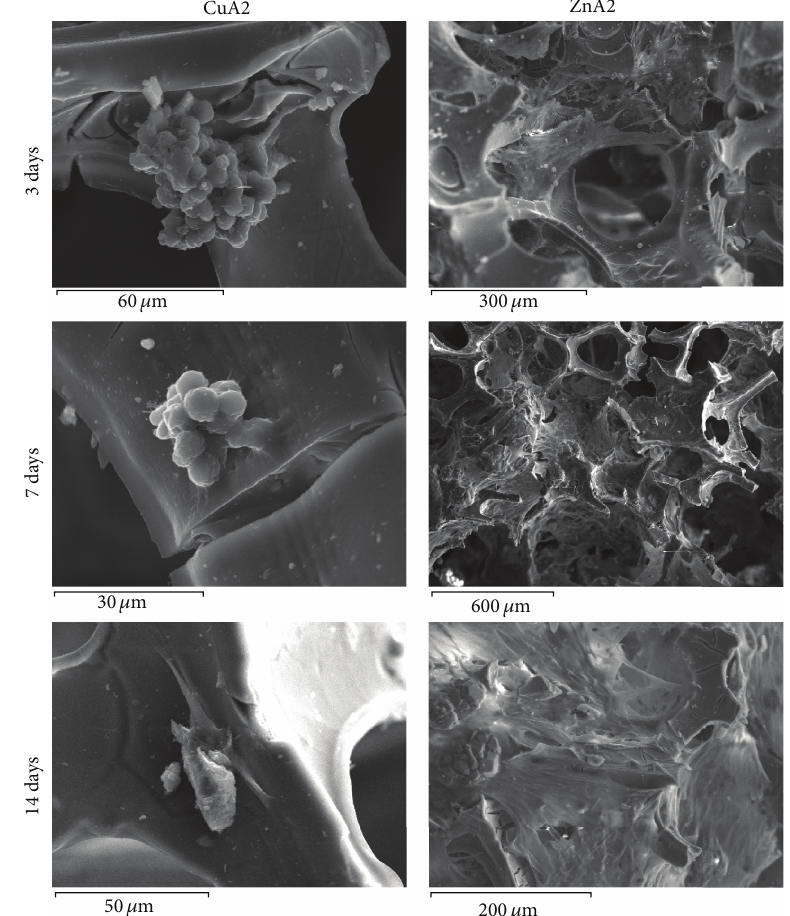
Figure 9: SEM microphotographs of CuA2 and ZnA2 scaffolds seeded with DPSCs after 3, 7, and 14